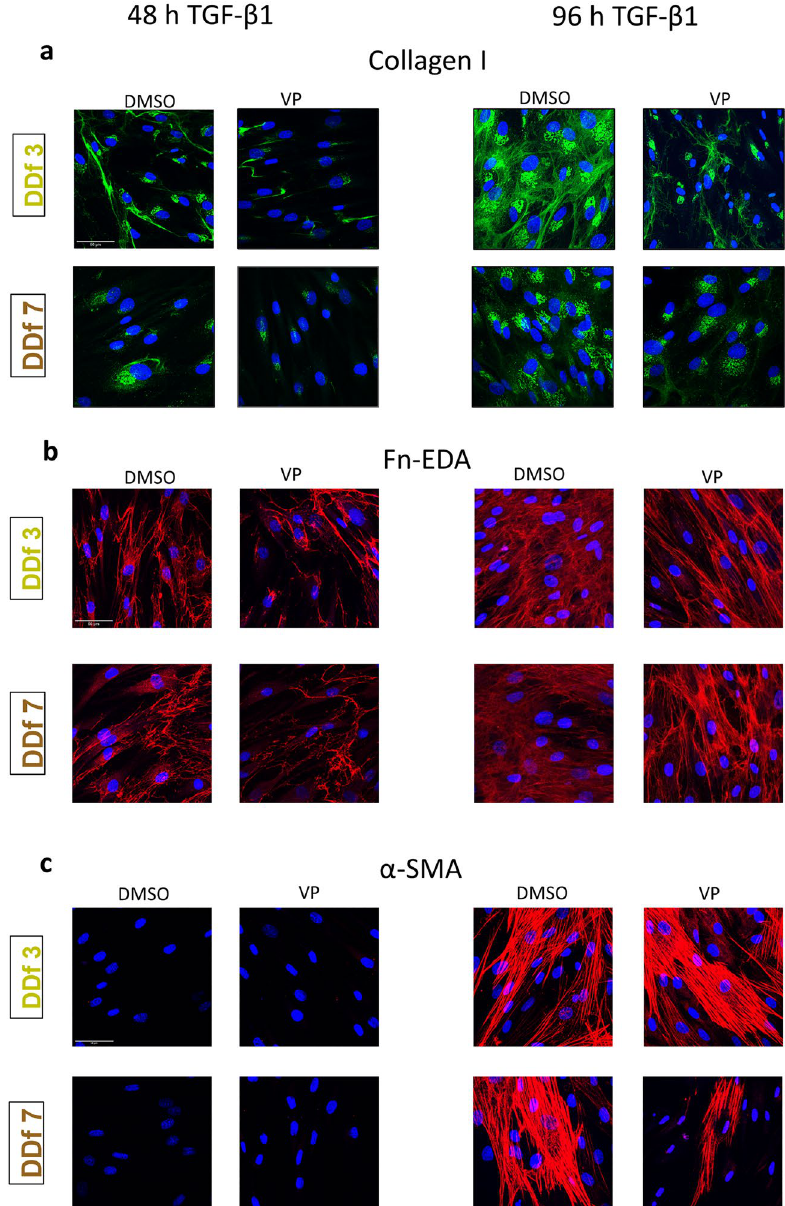
Figure 5. Immunofluorescence of hallmark proteins in fibrosis. ( a ) Synthesis and deposition of collagen type I after 48 and 96 h TGF-β1 stimulation in the presence or absence of VP. Immunofluorescence of intracellular and extracellular collagen type I. ( b ) Deposition and morphology of Fn-EDA after 48 and 96 h TGF-β1 stimulation in the presence or absence of VP as revealed by immunofluorescence staining. ( c ) Myofibroblast differentiation after 48 and 96 h TGF-β1 stimulation in the presence or absence of VP as revealed by immunofluorescence staining of α-SMA. Iimages are shown from donors with a high and a low expression (high: patient DDf3 and low: patient DDf7; for mRNA data see Figs. 3 and 4) (magnification 63x, scale-bar = 50